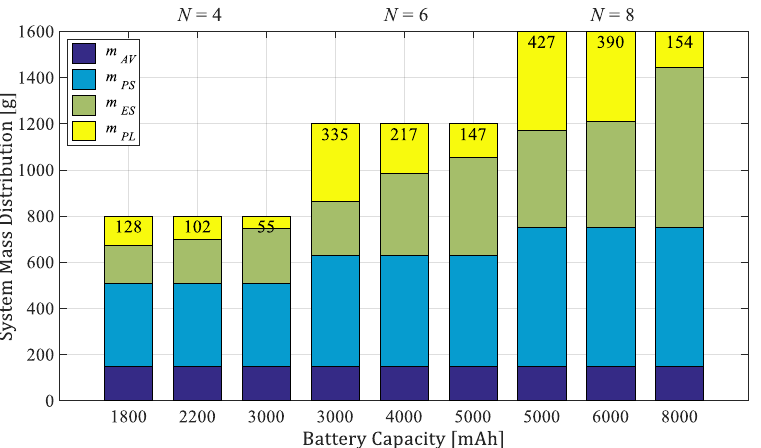
Figure 6. Mass distribution of the aircraft series with 7024 propellers and 3S batteries (TWR = 1.7).